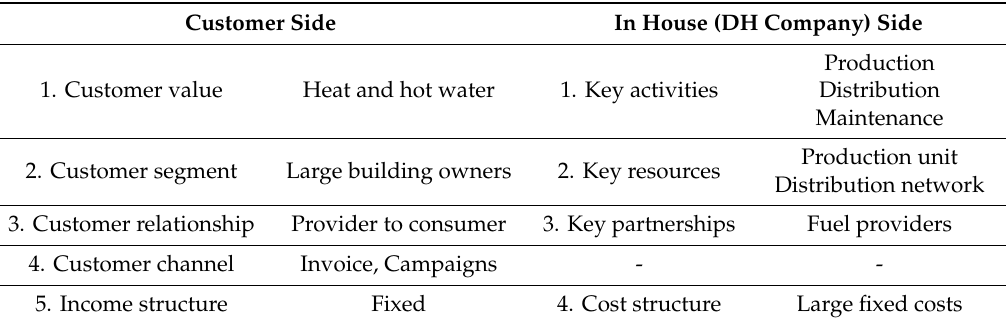
Table 1. The features of the conventional DH business